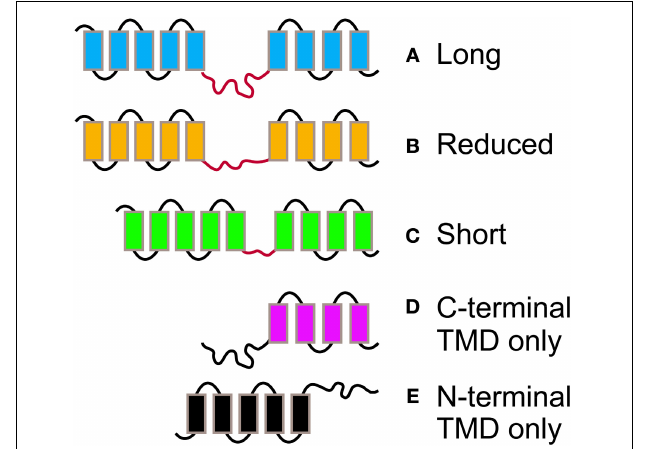
FIGURE 3 | The different morphologies postulated for PIN proteins. PIN proteins are classified into 5 groups according to their length and structure. PINs with two complete TMDs and a long (A) , reduced (B) , or short (C) central hydrophylic loop. PINs with reduced protein length and presence of a TMD at the C-terminal (D) , or N-Terminal end (E)